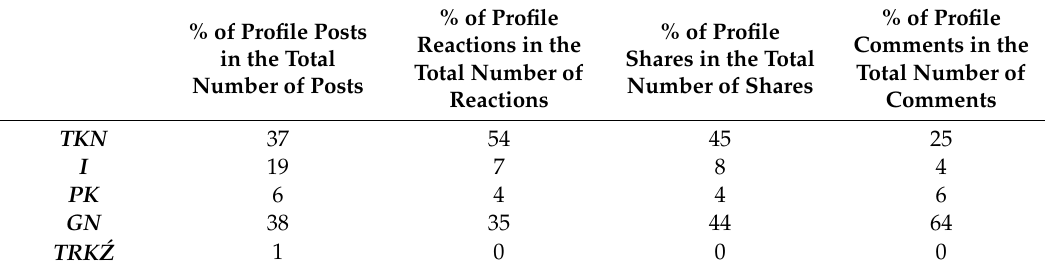
Table 16. Share of profile posts and profile reactions in the context of total posts and reactions (%). % of Profile % of Profile % of Profile Posts % of Profile Reactions in the in the Total Shares in the Total Total Number of Total Number Number of Posts Number of Shares Reactions